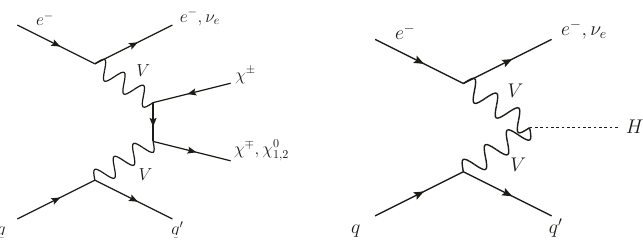
Figure 4 . Example of dominant Higgsino (left) and Higgs (right) production processes at e colliders. V = W (cid:6) or Z as required.